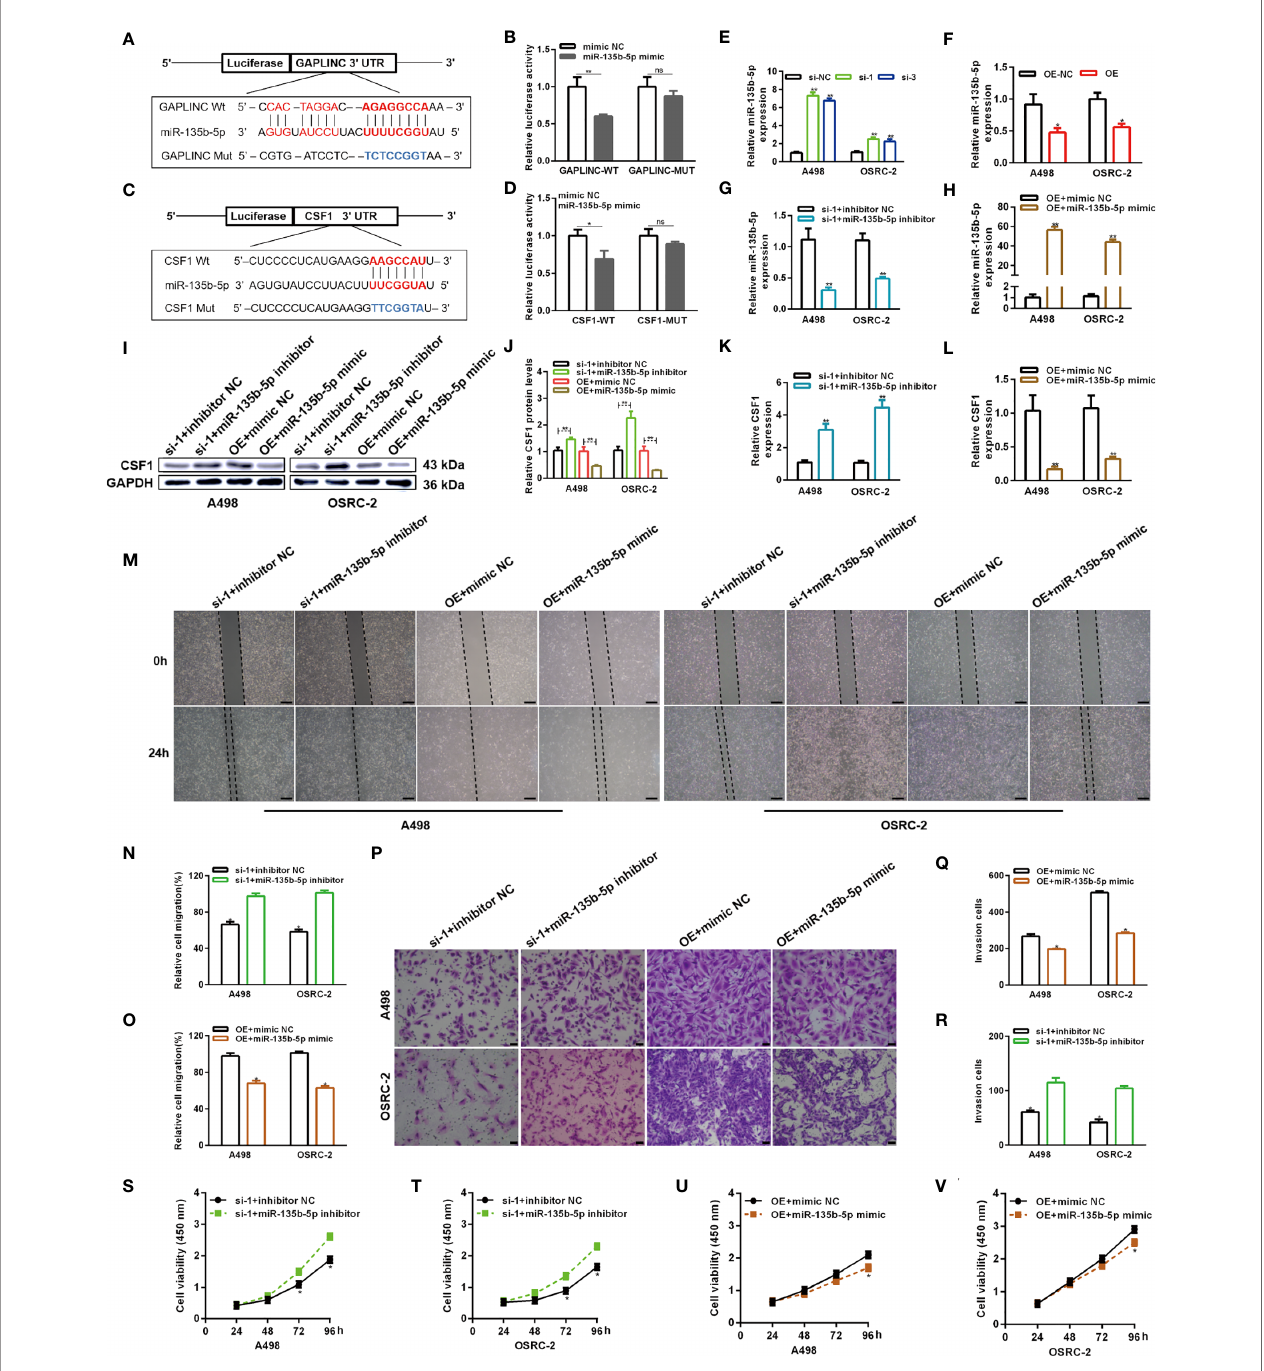
FIGURE 5 | GAPLINC promotes RCC tumor progression via the miR-135b-5p/CSF1 axis. (A – D) Luciferase reporter assay of A498 cells cotransfected with miR- 135b-5p mimics and luciferase reporters containing the wild-type or mutant 3 ′ UTRs of GAPLINC or CSF1. (E, F) MiR-135b-5p expression after silencing or overexpressing GAPLINC in A498 and OSRC-2 cells by RT-qPCR. (G, H) The relative expression of miR-135b-5p in RCC cells transfected with si-1/OE vector alone or cotransfected with miR-135b-5p inhibitors/mimics. Western blot (I, J) and RT-qPCR (K, L) analysis of CSF1 protein and mRNA expression levels after cotransfection with si-1+miR-135b-5p inhibitor or OE vector+135b-5p mimic. Wound healing (M – O) (scale bars = 200 m m) and Transwell (P – R) (scale bars = 50 m m) assays were employed to investigate the migratory capacity of si-1+miR-135b-5p inhibitor- or OE vector+135b-5p mimic-cotransfected RCC cells. The proliferation ability of RCC cells cotransfected with si-1+miR-135b-5p inhibitor (S, T) or OE vector+135b-5p mimic (U, V) was determined by CCK-8 assays. *p < 0.05; **p < 0.01; ns, no signi fi